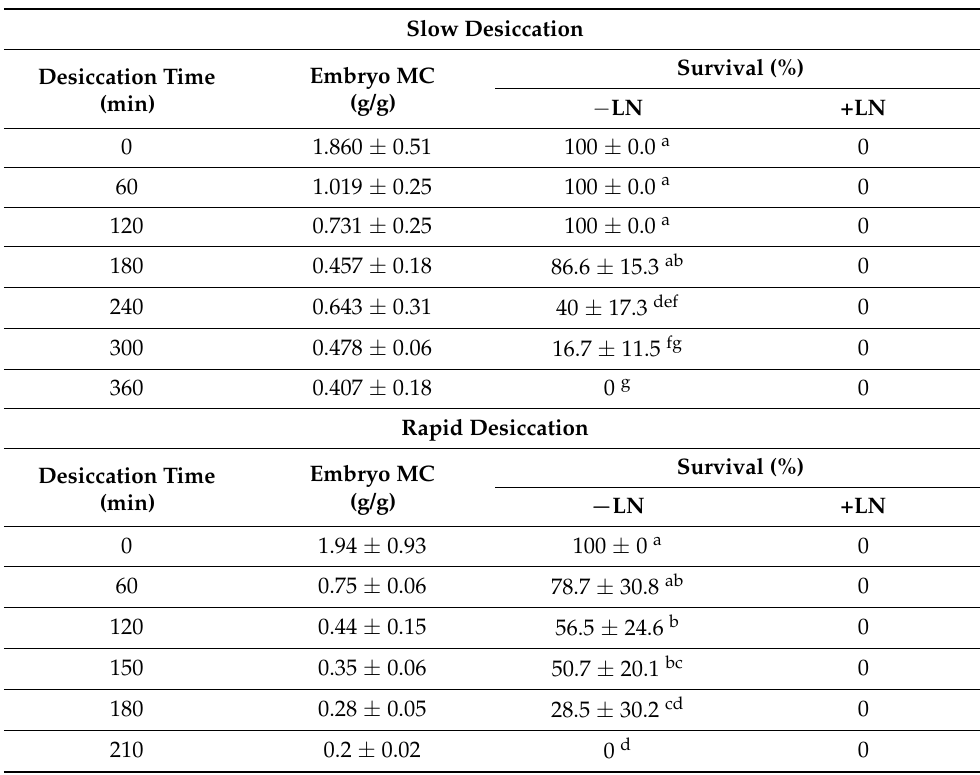
Table 1. Comparison of embryo moisture content (MC) and survival (%) before (-LN) and after (+LN) liquid nitrogen cryopreservation for embryonic axes desiccated slowly (0–6 h) or rapidly (0–210 min). Results are displayed as mean ± SD. Survival values for each desiccation method followed by the same letter do not differ significantly (Fisher’s, p < 0.05; N = 10).